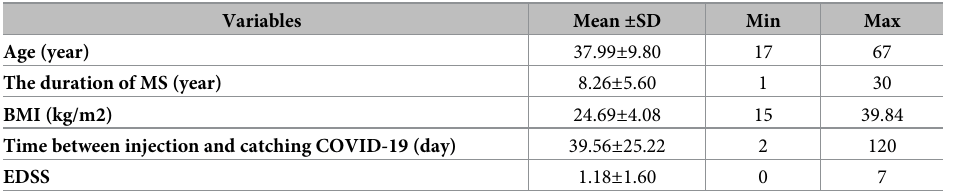
Table 2. Mean and standard deviation of variables.